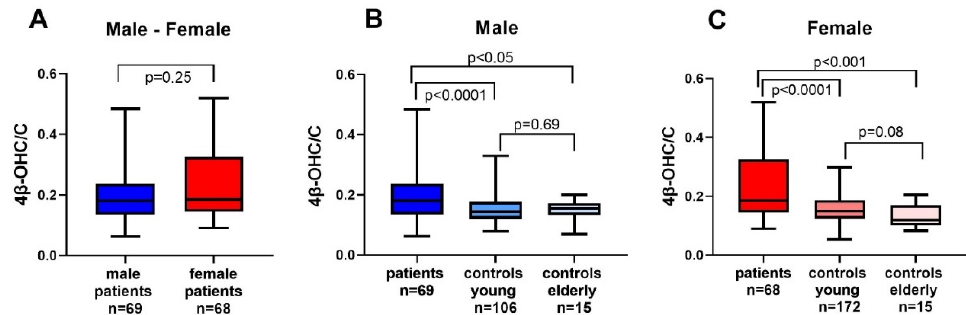
Figure 1. Differences in 4 β -hydroxycholesterol/cholesterol ratio (4 β -OHC/C) between ( A ) male and female patients ( B ) male cancer patients, young and elderly controls, and ( C ) female cancer patients, young and elderly controls.